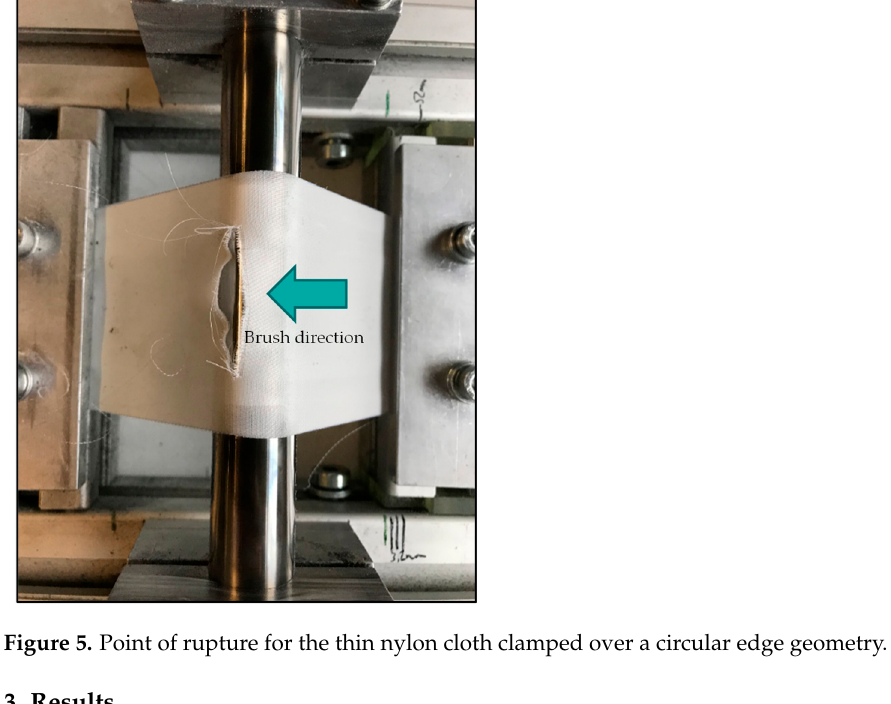
7 Table 2. Properties of tailings filtration filter media [17]. PP-Cloth